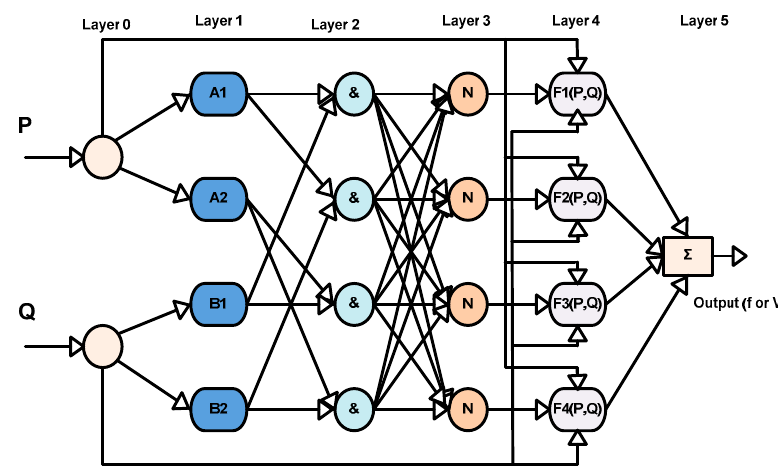
Figure 15. ANFIS typical structure.